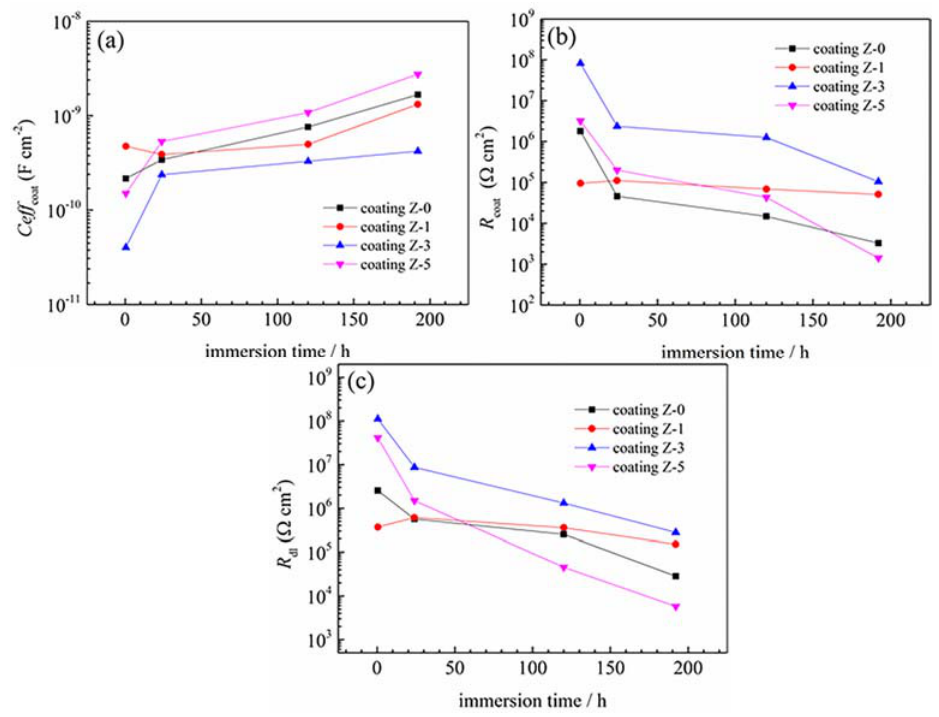
Figure 10. Variations of Ceff coat , R coat , and R ct with immersion time (values from Table 4).